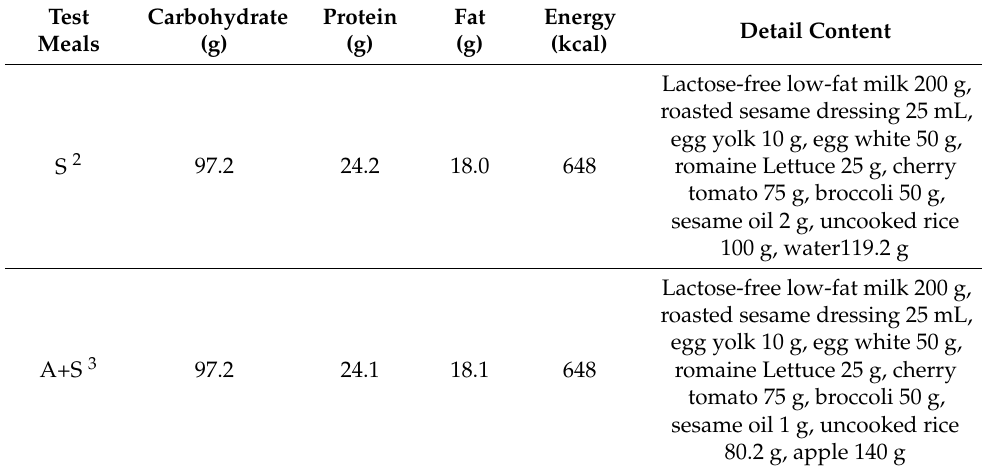
Table 1. The composition, macronutrient and energy contents of the lunch test meals 1